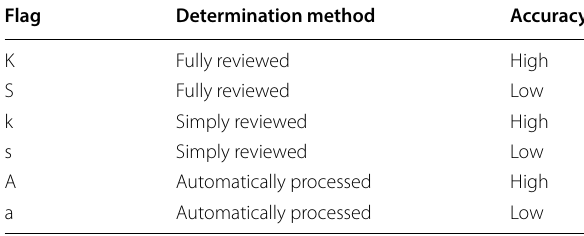
Table 1 Hypocenter flags